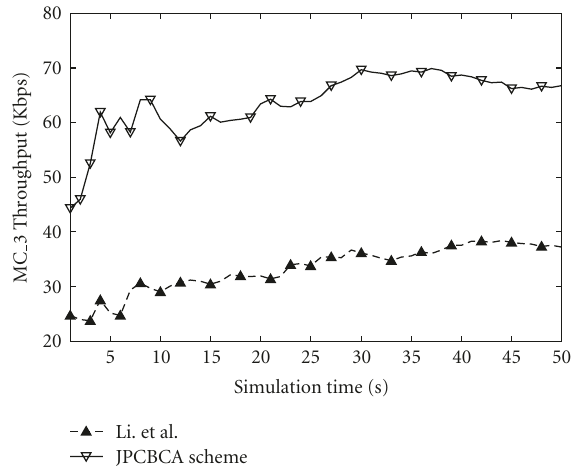
Figure 11: Private Client Throughput Comparison. This figure shows the aggregate throughput for MC 3. The throughput is higher for the joint power control, base station assignment, and channel assignment scheme since MC 5 is connected to the MBS. The client MC 5 is connected to in our scheme since the MBS is not yet in the threshold. In the event that MBS reaches its threshold, then MC 5 connects to FBS 3 in our scheme and the throughput value is the same as in